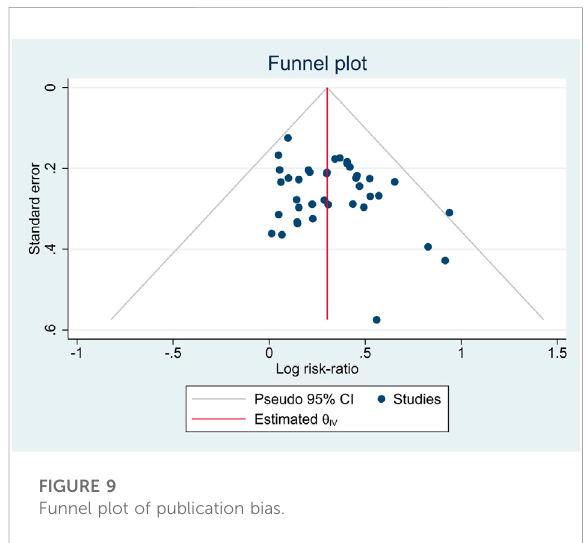
FIGURE 9 Funnel plot of publication